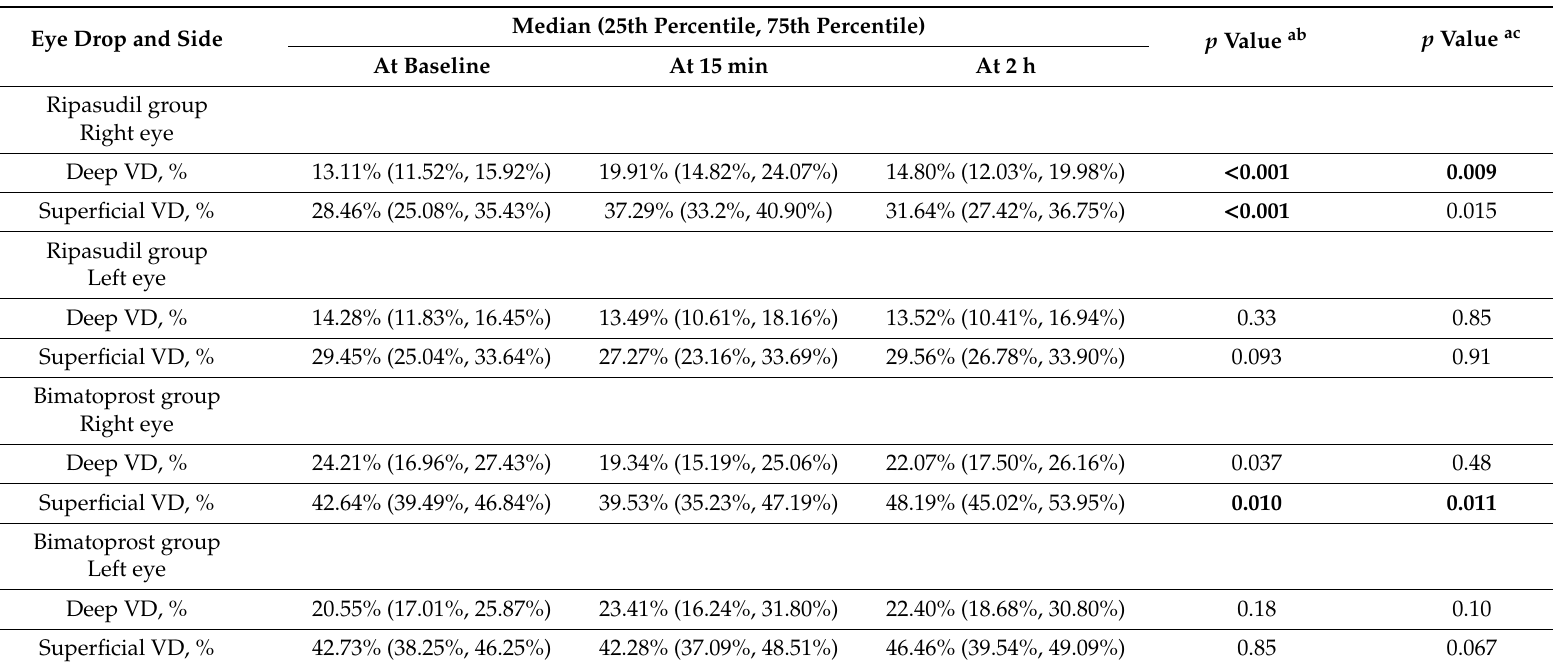
Table 2. Vessel densities (VDs) in the deep and superficial layers after ripasudil or bimatoprost